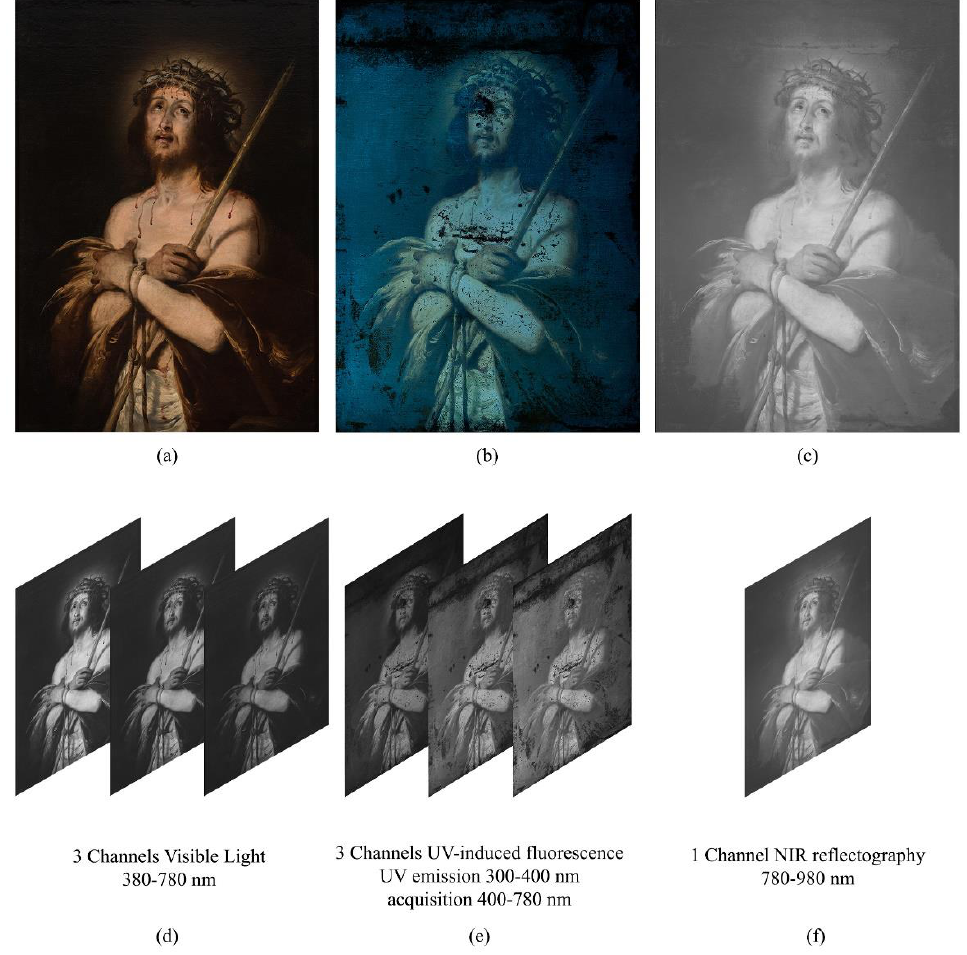
Figure 2. Phase I, stage 1—Ecce Homo by Bernardo Strozzi, oil on canvas, 1620–1622, 105 × 75 cm 2 : ( a ) Standard RGB; ( b ) UV-induced fluorescence; ( c ) NIR reflectography; ( d – f ) Respective spectral Channels of the acquired images. Images captured by Paolo Triolo, under permission of the Ministry of Cultural Heritage and Activities and Tourism, National Gallery of Palazzo Spinola, Genova, Italy.